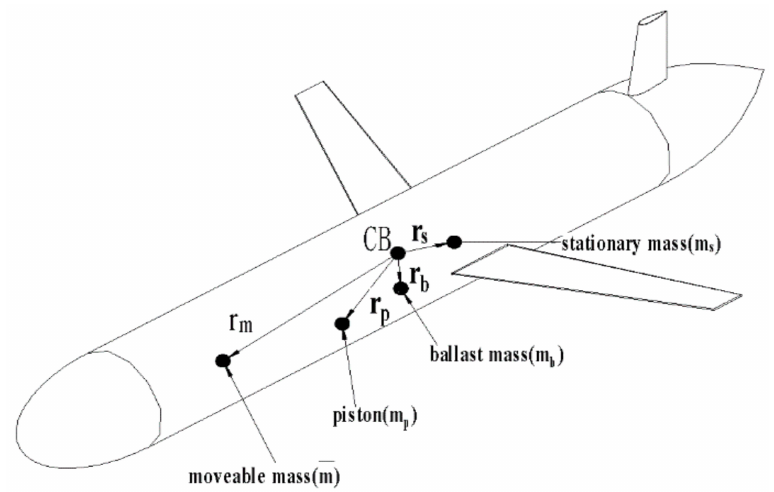
Figure 3. Illustration of glider